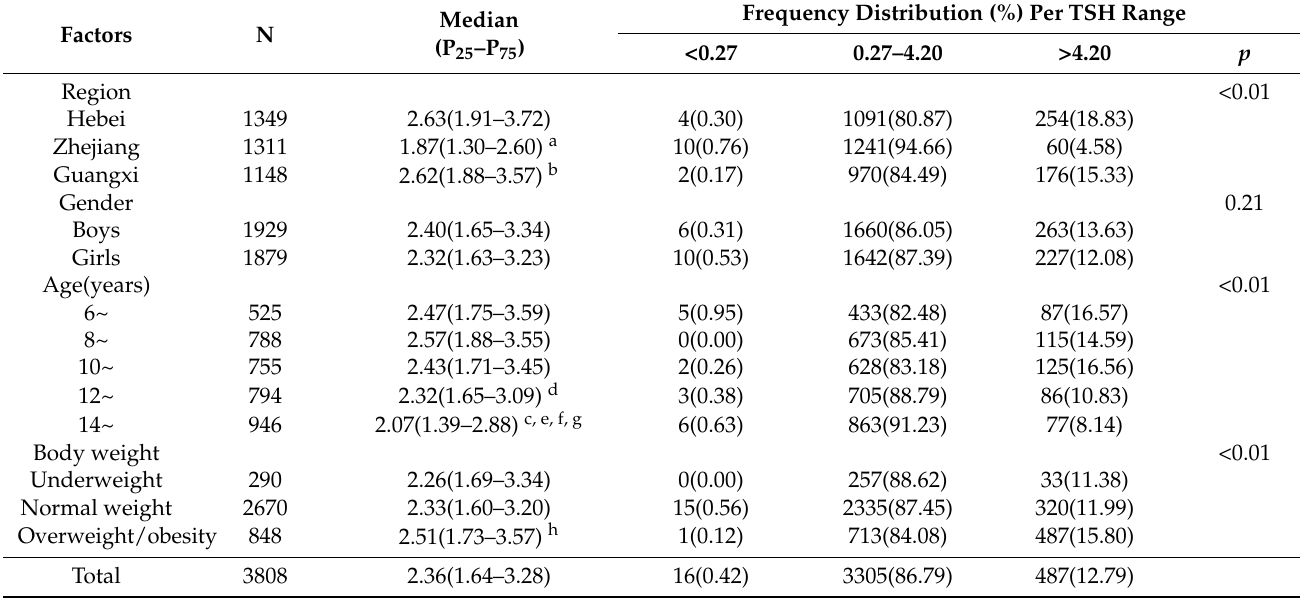
Table 3. Median and distribution of TSH of Chinese school-age children